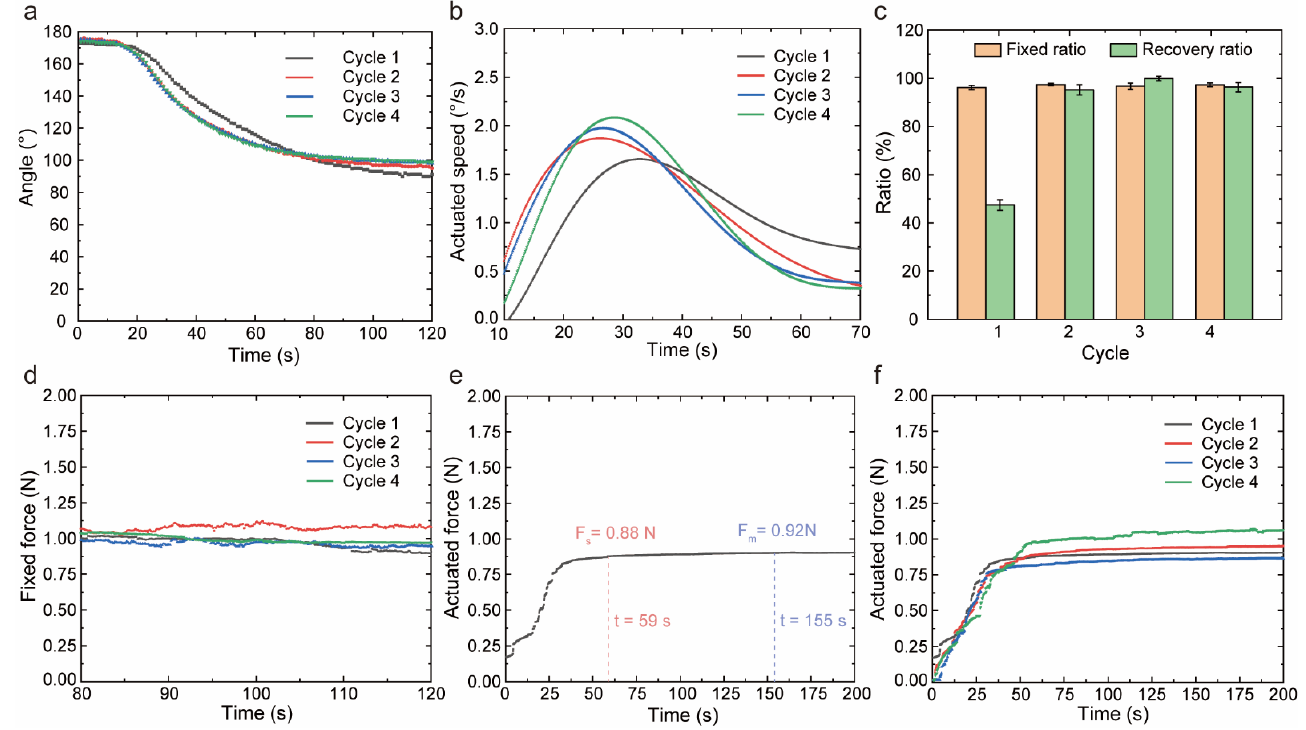
Figure 2. The cycle shape memory properties and actuation performances of PEEK. ( a ) The variation in angle in cycle shape recovery process. ( b ) The angular speed in real-time for four cycles. ( c ) The shape fixed ratio and shape recovery ratio in cycle shape memory behavior. ( d ) The fixed force in cycle shape fixed process. ( e ) The recovery force in real-time. F s was the steady force and F m was the maximum force. ( f ) The recovery force in the cycle shape recovery process.